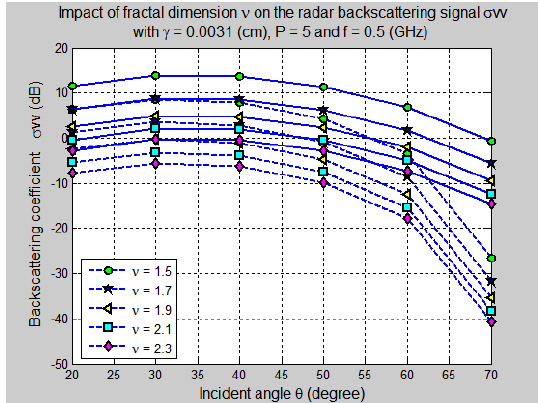
Figure 4: Backscattering coefficient dependence on fractal parameter ν at VV polarization for bare soil (dashed line) and for vegetated soil (full